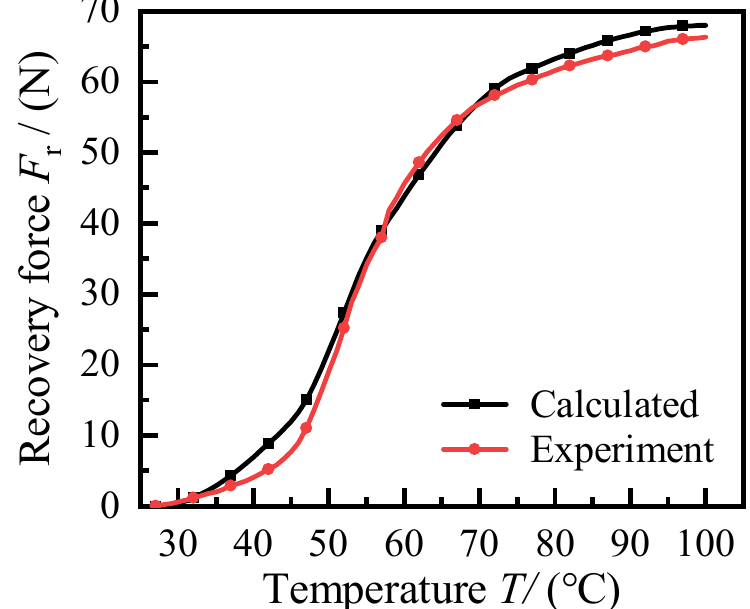
Figure 8. SMA spring reversion versus temperature curves.